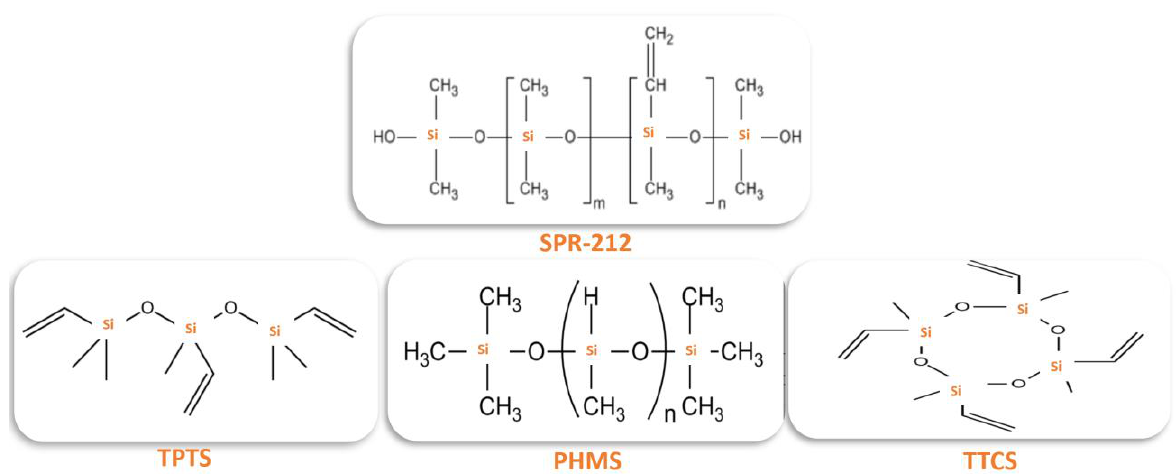
Figure 1. Structure of oligomers used for synthesis of the ceramic powders.